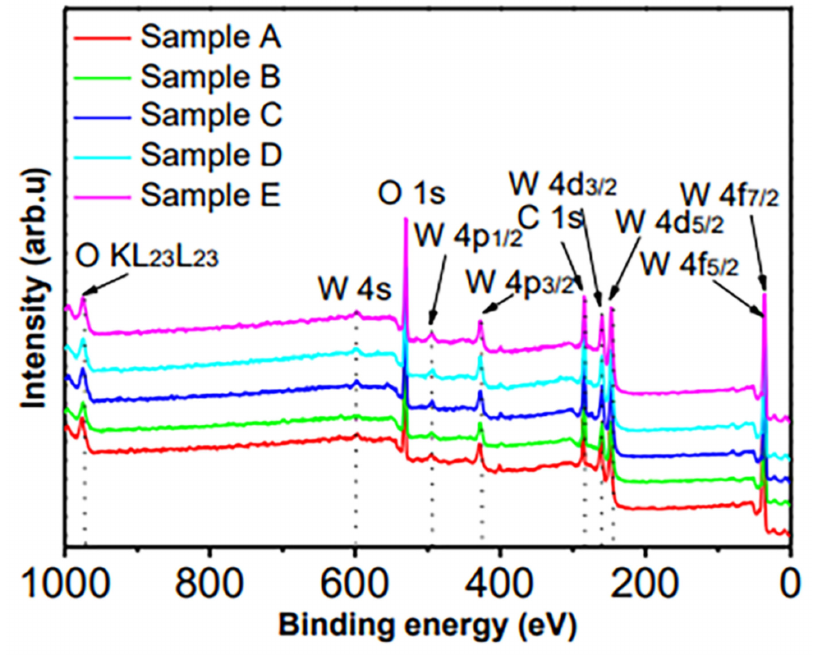
Figure 3. XPS survey spectra of samples A − D. The XPS peaks are assigned according to Ref. [31]. These XPS peaks indicate that the as-synthesized aggregates contain the W, O and C elements. Table 4. Binding energy (eV) of deconvoluted XPS peaks in Figure